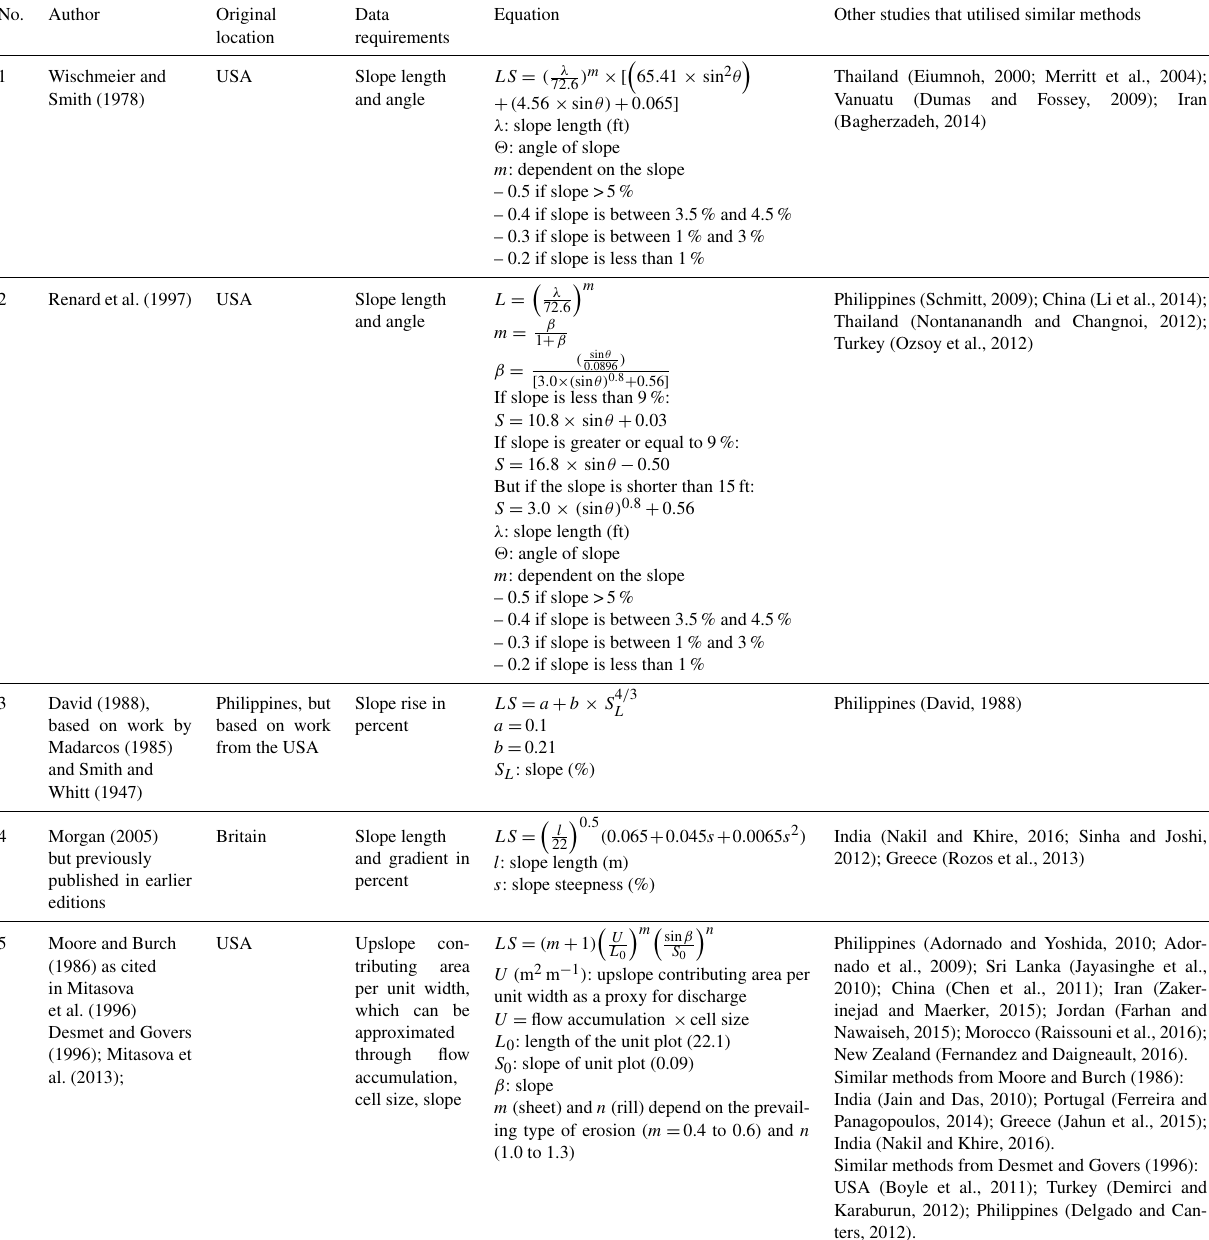
Table 6. Summary of methods of calculating LS factor, original locations, and other studies that used these